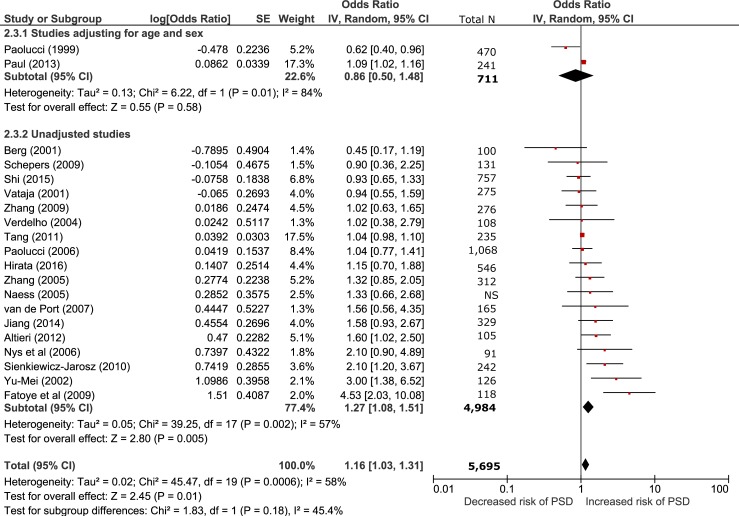
Sensitivity analysis comparing studies adjusted for age and sex vs unadjusted studies.